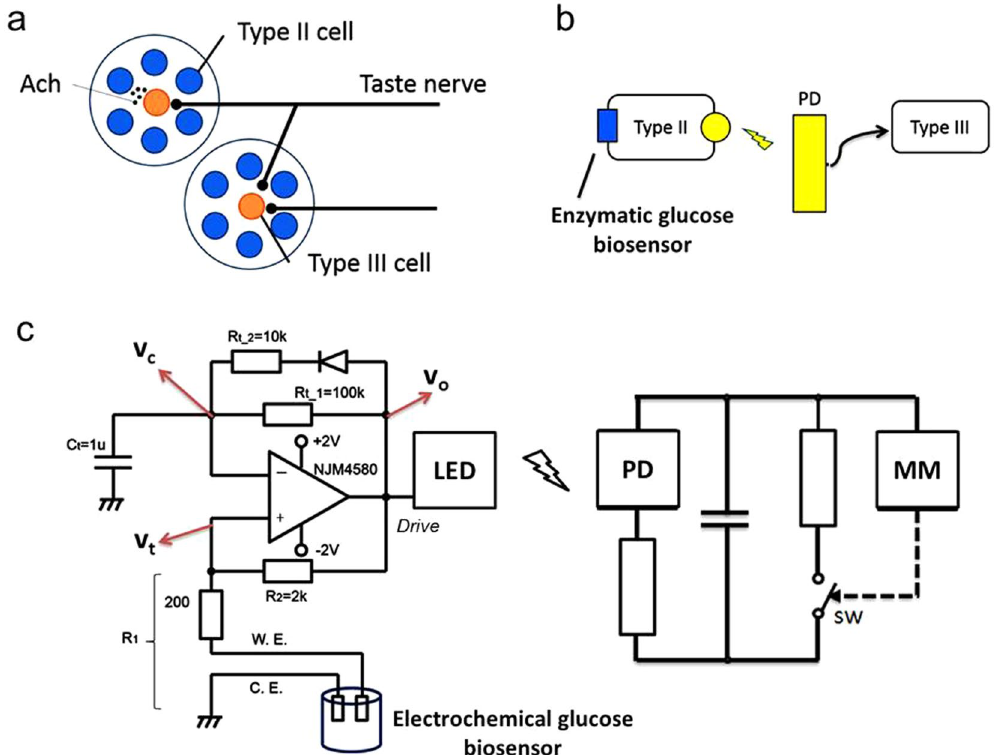
Figure 2. Illustration of electrical circuit attached to glucose biosensor. ( a ) Schematic diagram of mouse taste bud network: type II cells detect chemical components and release signalling molecules, such as Acetylcholine (Ach), into the extracellular space in the taste bud (paracrine signalling). Ach travels to nearby type III cells, which are responsible for transducing the obtained signals to the brain. ( b ) Schematic design of taste bud- inspired circuits: type II cell attached to an amperometric glucose biosensor to obtain signals from the biosensor and transmit signals to the type III cell using light emission. The type II cell circuit produces a signal to induce changes in nearby type III circuit via light emission, as for the paracrine signalling. ( c ) Design of the frequency- based pulse generator circuits includes an infrared LED in the first layer (type II) and an infrared-based photodiode in the second layer (type III) for signal transmission.